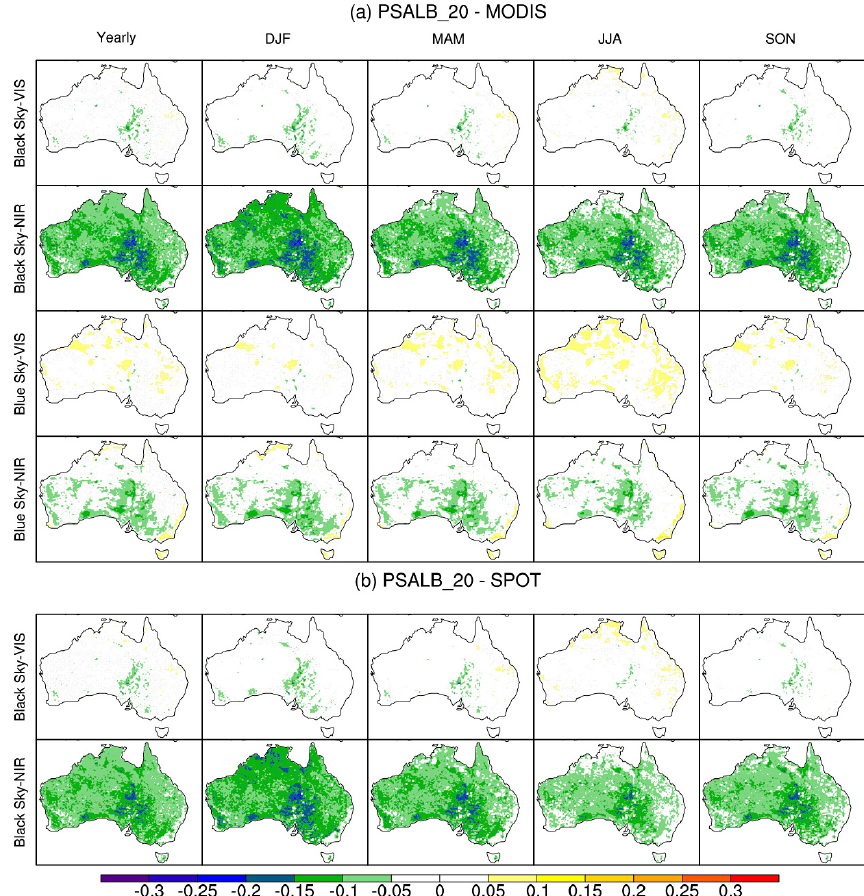
Figure 12. Same as in Fig. 6 but for the PSALB_20